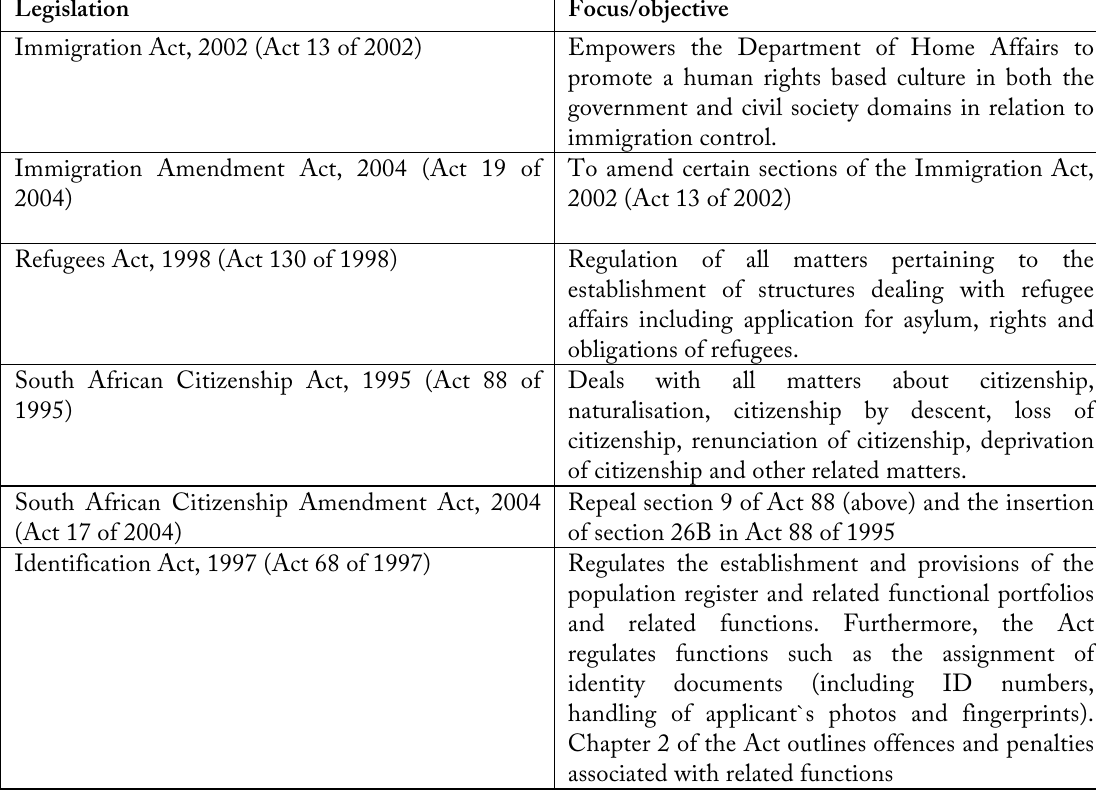
Table 2: Policies administered by the National Department of Home